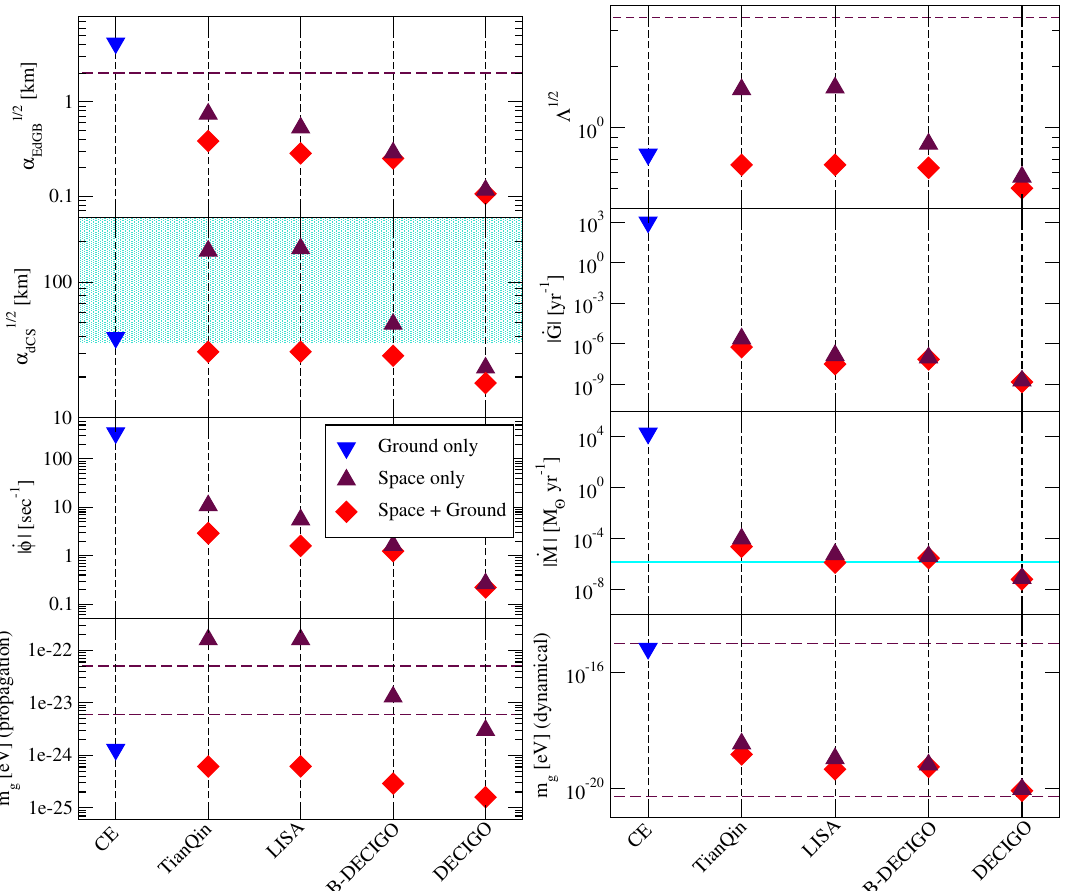
Figure 2. The 90% upper-bound credible level constraints on the parameters representative of the modified theories of gravity considered in [88] for GW150914-like events. Bounds are presented for Einstein dilaton Gauss–Bonnet (EdGB) gravity, dynamical Chern–Simons (dCS) gravity, scalar tensor theories, noncommutative gravity, varying- G theories, black hole (BH) mass-varying theories, and massive graviton (dynamical and propagation). For EdGB, dCS and scalar-tensor theories, the bounds are only meaningful outside of the blue shaded region where the small coupling approximations are violated. The dashed maroon lines correspond to the current bounds in the literature. The cyan line in the second-to-last right panel corresponds to the Eddington accretion rate: the maximum rate GW150914-like events can accrete in-falling matter under spherical symmetry. This figure is taken and edited from